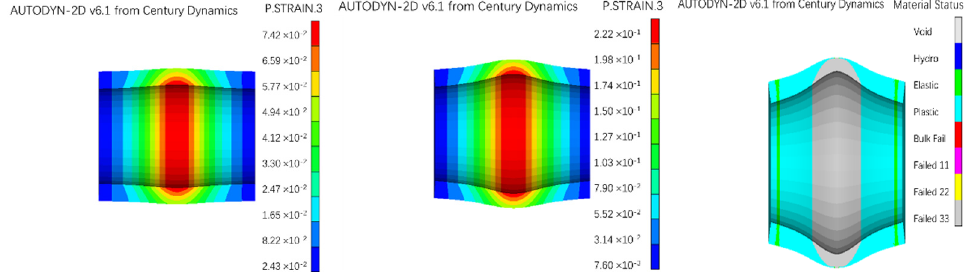
Figure 8. Circumferential strain cloud of 20 mm-thick shell at 233, 403, and 623 g TNT.